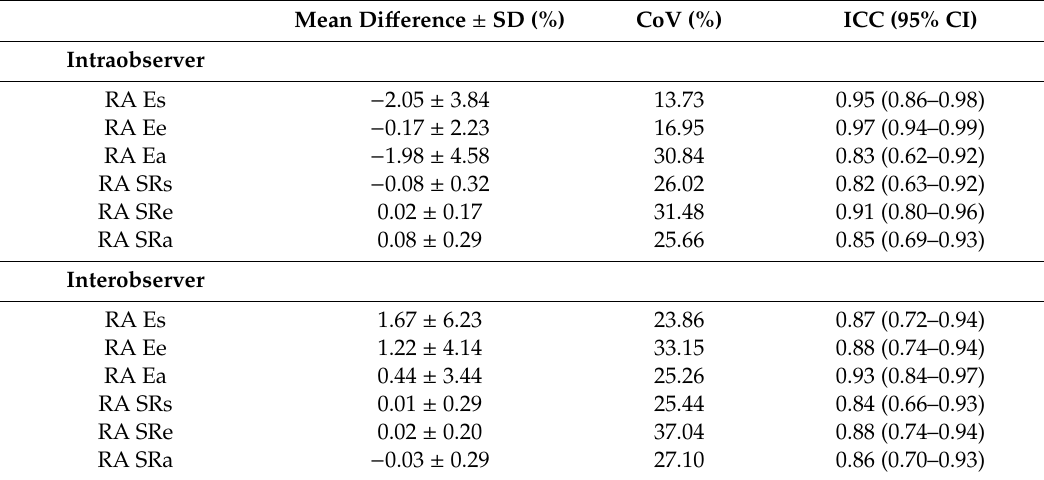
Table 3. Reproducibility of right atrial strain